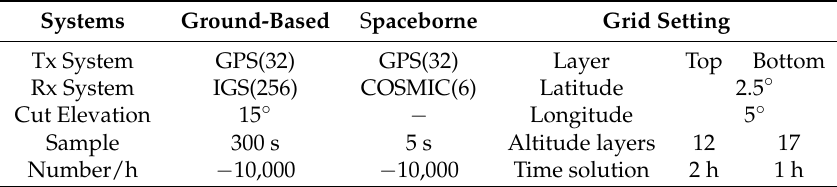
Figure 5. Data processing flow in the ionospheric assimilation process. Table 1. Assimilation parameter